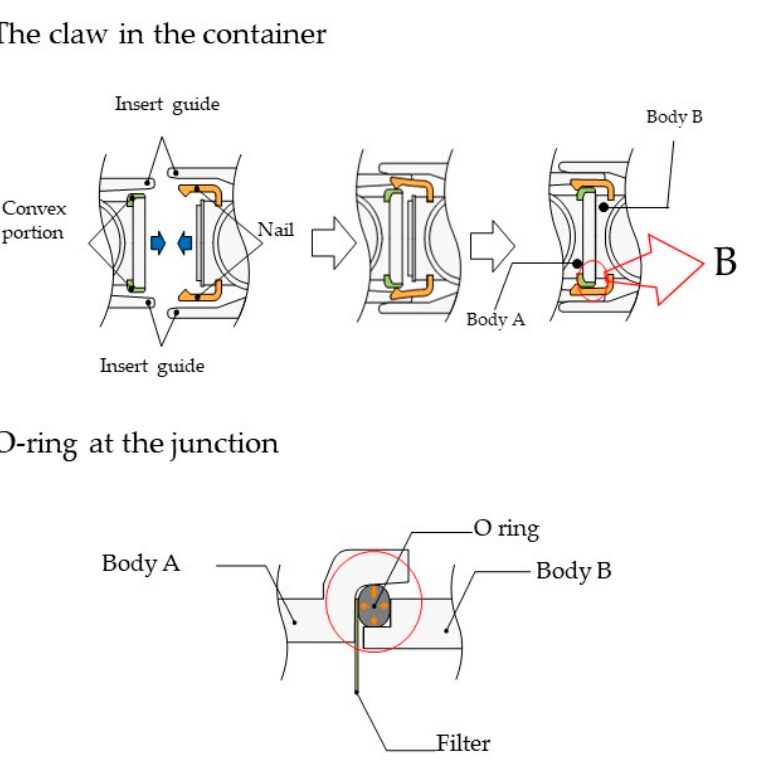
Figure 3. The mechanism used for leakage prevention and the methods used to prevent it. The containers (Body A and Body B) are tightly coupled via the insert guide to prevent leakage. ( a ) The claw in the container of Body B is structured to constrict Body A tightly past the convex portion of the container. ( b ) The O-ring at the junction of Body A and Body B prevents leakage.